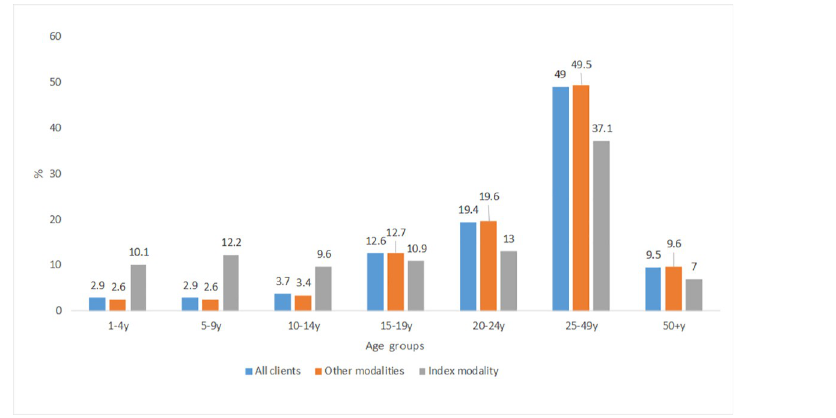
Fig 2. HIV positivity by age and